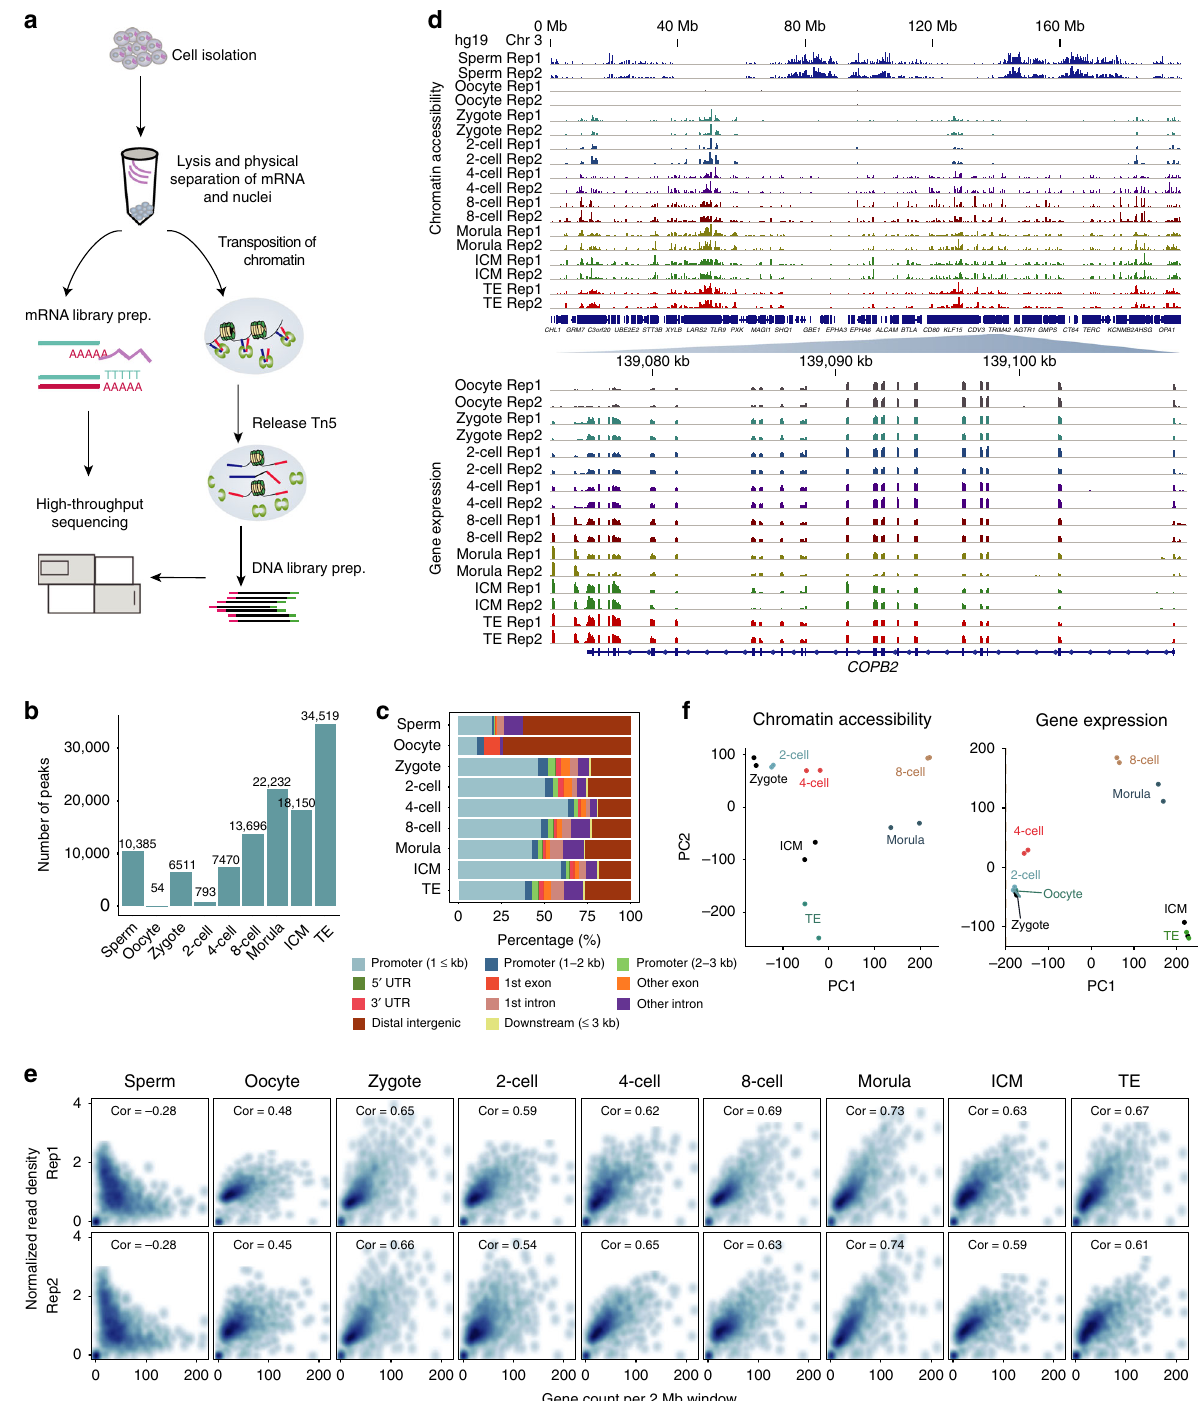
Fig. 1 The accessible chromatin landscapes of human pre-implantation embryos. a Schematic representation of LiCAT-seq for simultaneous pro fi ling of chromatin accessibility and transcriptome with ultra-low-input of cells. b Number of accessible regions detected at the indicated stages of embryo development. c Genomic distribution of chromatin accessibility peaks detected at the indicated stages. d Genome browser view of a representative region showing the chromatin accessibility and gene expression signals at each developmental stage. e Scatterplot of gene density ( x axis) versus normalized read density ( y axis) at each developmental stage. f Principal component plots of normalized chromatin accessibility and gene expression signals